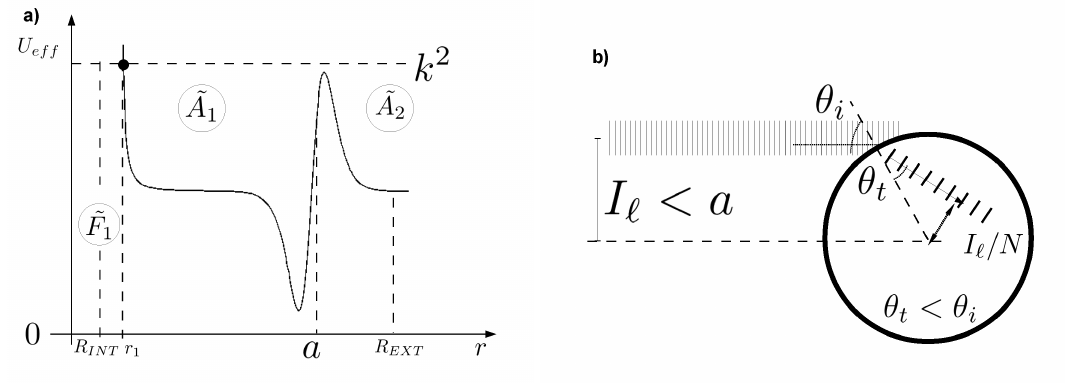
Figure 6 - In ( a ): Similar to Fig. 5, shows the “Energy budget” mechanism associated with the “excitation” of the Transmission Resonances (TR) associated to one classically forbidden region ˜ F 1 and two classically allowed regions ˜ A ˜ A 1 and 2 respectively. In ( b ) the figure shows the equivalent ray trajectory picture, where the incident acoustic plane wave, for a given impact parameter I (cid:96) , makes a direct collision with the spherical surface of the bubble. A fraction of the incident beam is refracted at angle θ t which is smaller than the incidence angle θ i